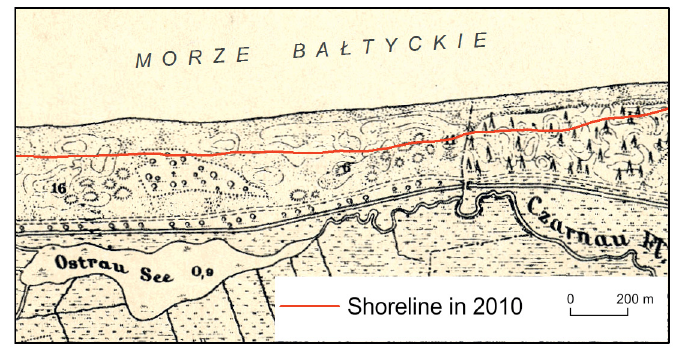
Fig. 5. Fragment of the Ostrau sheet of Messtischblätter topographic map at the scale of 1:25,000 presenting the sea coast between Jastrzębia Góra and Karwia (134.7–137 km); dislocation (withdrawal) of the coastline resulting from the erosion action of the sea, occasionally reaches approximately 150